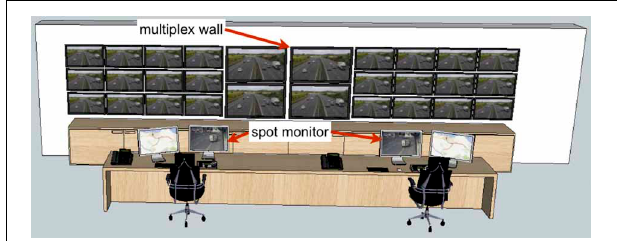
FIGURE 1 | Prototypical layout of modern provincial CCTV control room layout similar to that used by the Tayside Police. 3D model adapted from Google SketchUp program by artist “STUFF & STUFF.” Each operator has their own controllable spot monitor, an additional monitor, a computer keyboard a camera control keypad and a telephone headset to wear. Metropolitan area control rooms may feature more operators and a larger array of screens on the